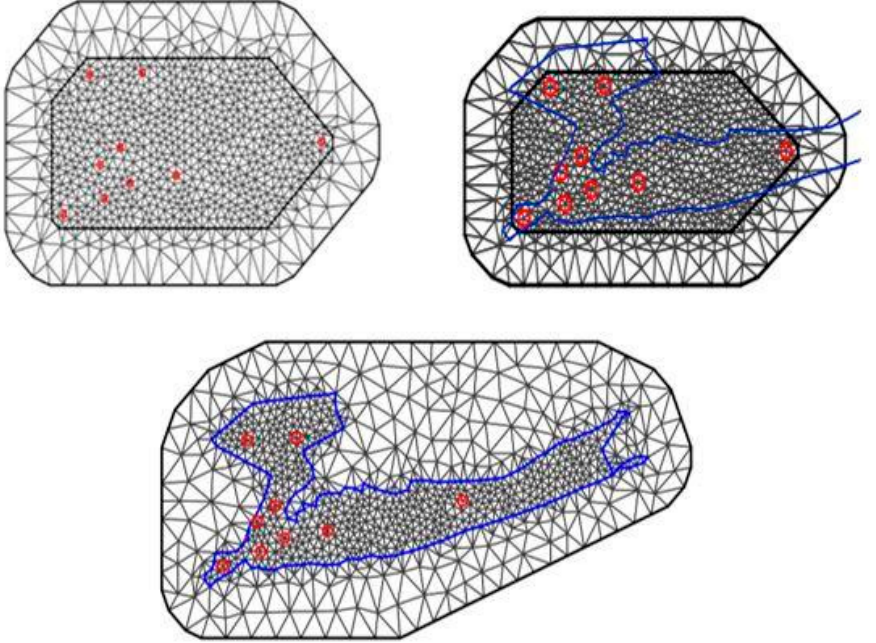
Figure 7. Stochastic partial differential equation (SPDE) mesh without boundary (top) and with the boundary of the study region (bottom). Locations of the weather stations in the study counties are highlighted as red circles. Blue line depicts the boundary region for the entire study area.